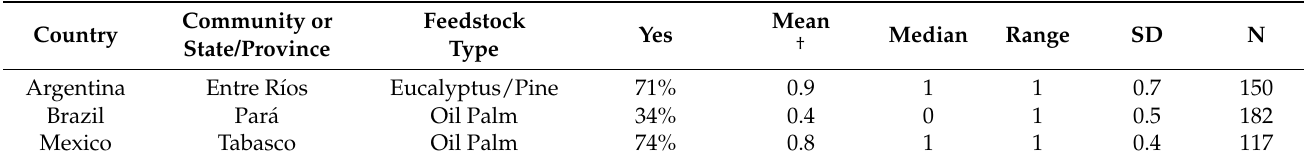
Table 3. Responses to the statement “Bioenergy feedstock cultivation provides bird habitat.” † Likert Scale: 0 = No, 1 = Yes. Country